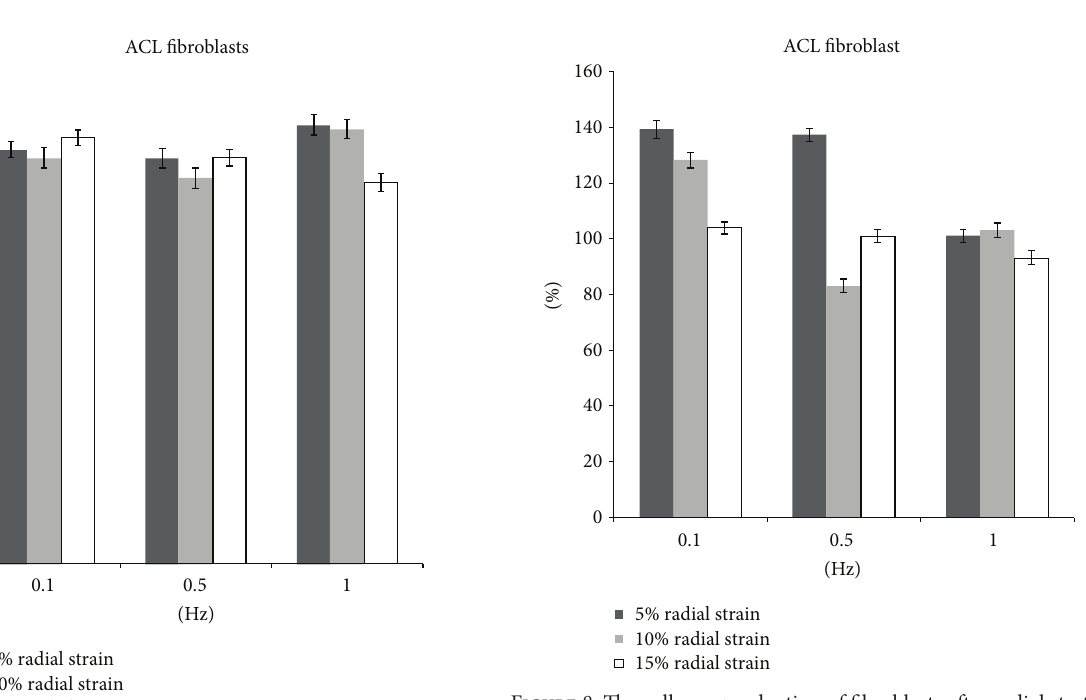
Figure 8: The collagen production of fibroblasts after radial stretch